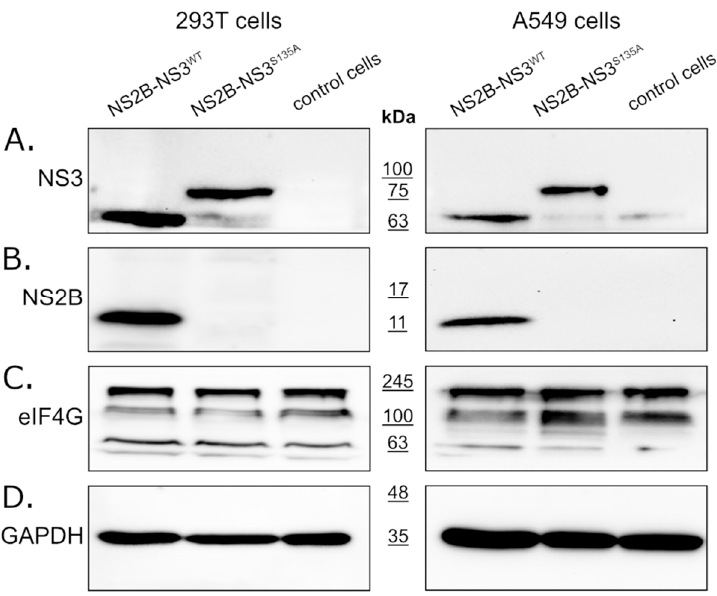
Figure 1. Expression of active and inactive NS2B-NS3 protease from Zika virus in eukaryotic cells does not affect eIF4G1 protein levels. The 293T (left panel) and A549 (right panel) cells expressing NS2B-NS3 WT or NS2B-NS3 S135A were assessed alongside control cells. Cells were harvested at 48 h after transfection, lysed, and analyzed by Western blotting. Protease expression was confirmed by the presence of NS3 ( A ) and NS2B ( B ) proteins. Anti-eIF4G1 antibody was used to detect and compare changes in eIF4G1 protein abundance in cells expressing active or inactive protease relative to control cells ( C ). The GAPDH protein was used as a reference to ensure that identical amounts of proteins were present in each sample ( D ).